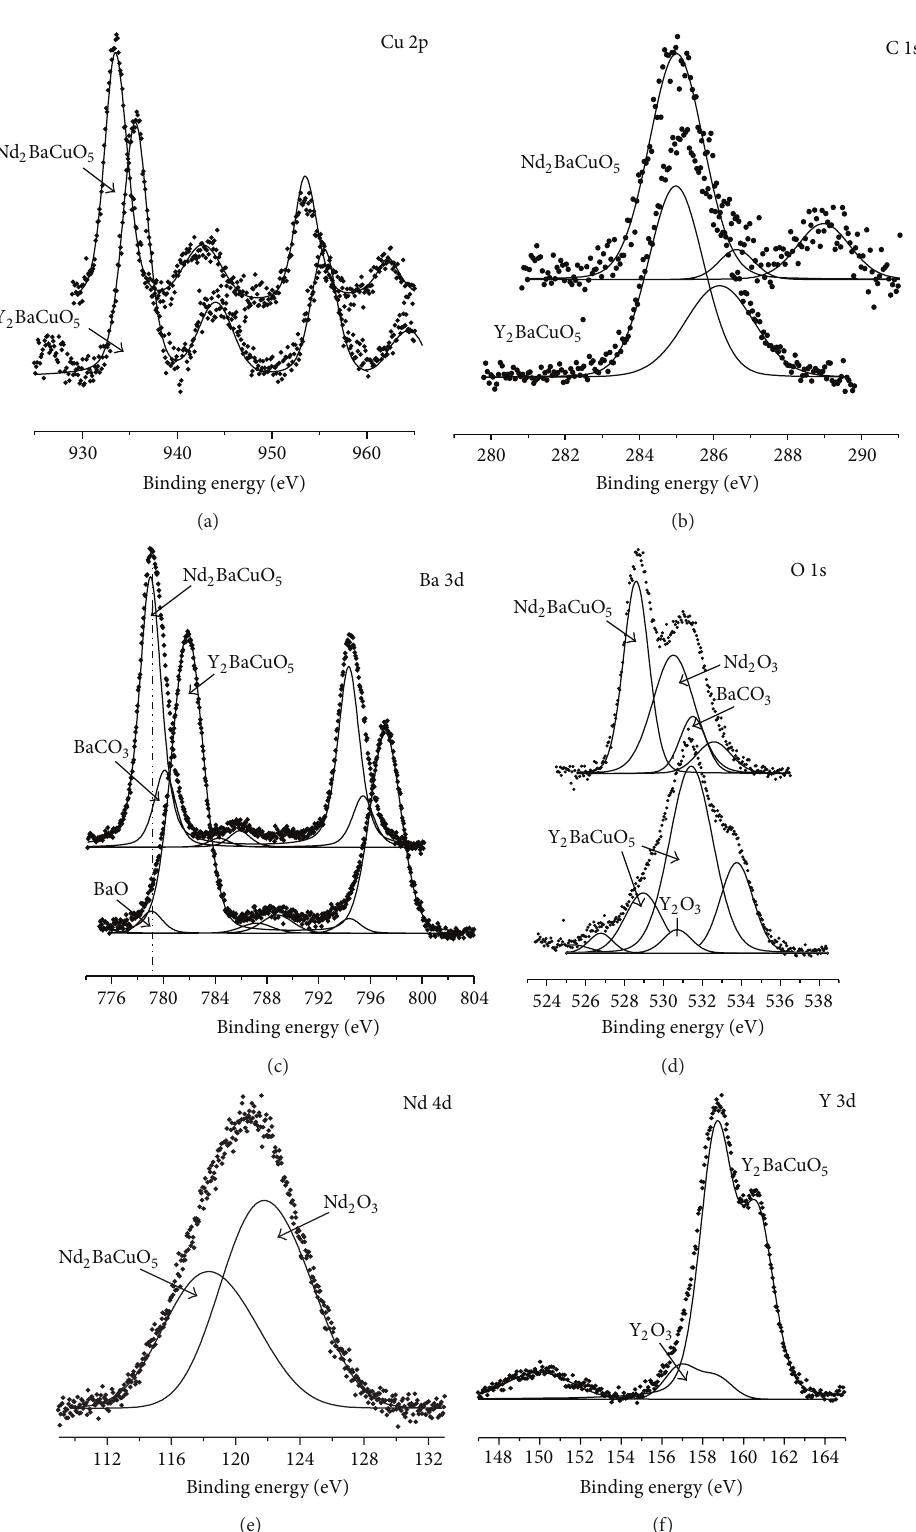
Figure 1: XPS spectra of Y 2 BaCuO 5 and Nd 2 BaCuO 5 oxides. The peaks related to the main oxide are marked by bold lines. The ordinate hereinafter is the intensity of the XPS signal in arbitrary units. To reduce the figure size, the y -axis itself is not